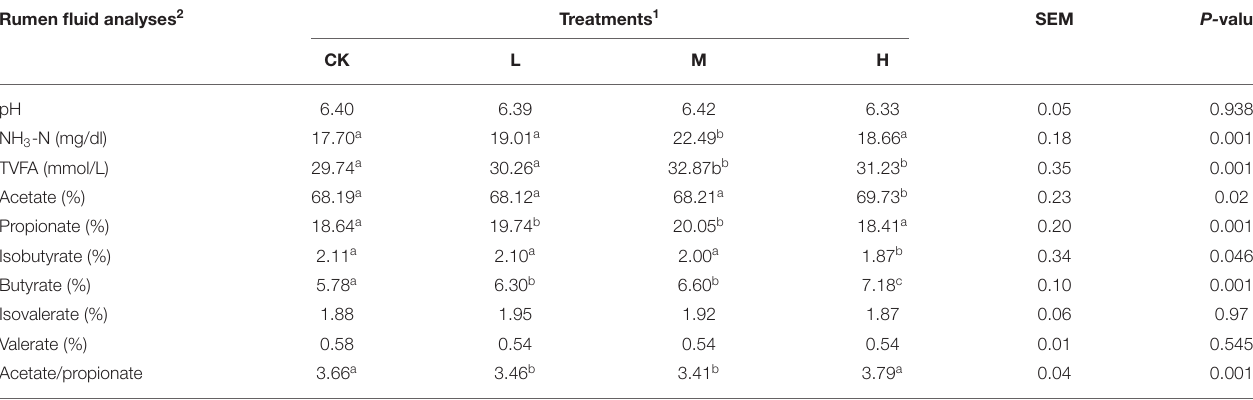
TABLE 2 | Influence of Selenium dose rate on rumen fermentation parameters in Tibetan sheep. Rumen fluid analyses 2